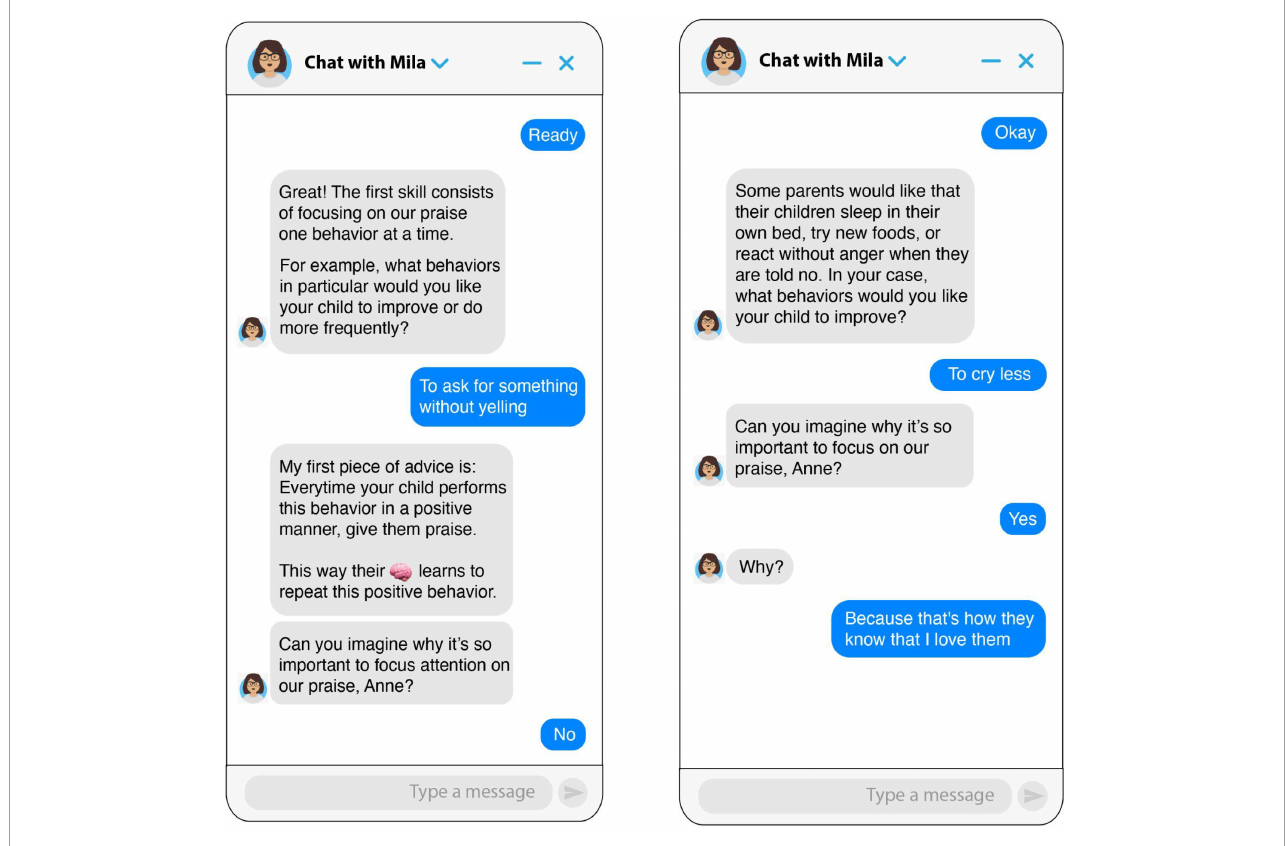
FIGURE1 Screenshots of the chatbot teaching the focus